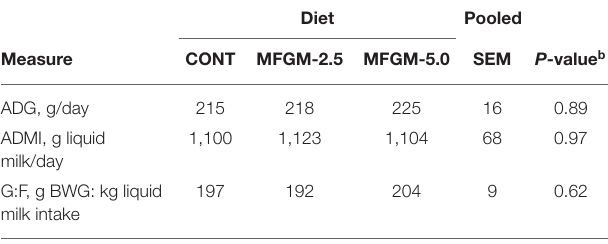
Frontiers in Pediatrics |